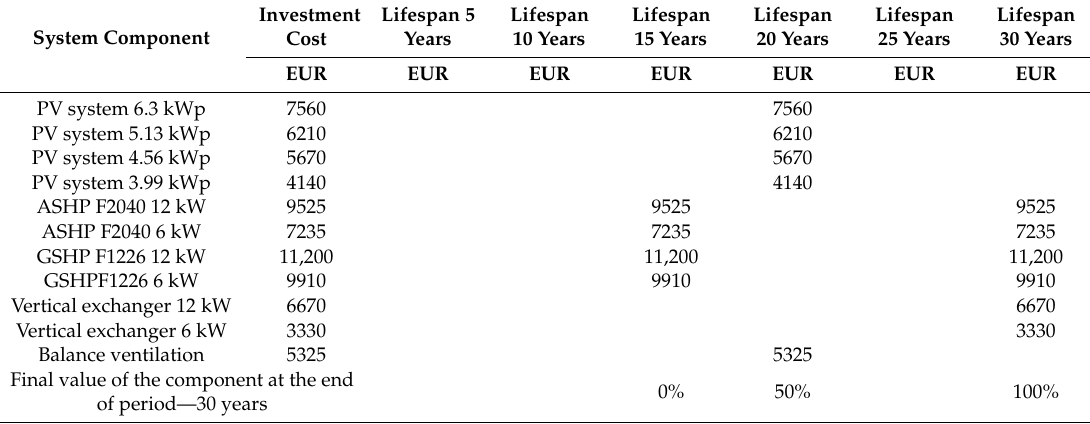
Table 18. Replacement cost and lifespan of building systems.